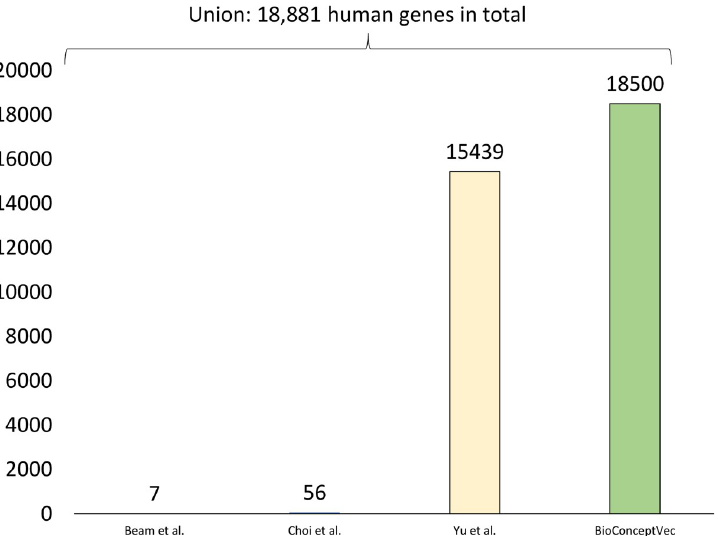
Fig 4. Gene coverage results in terms of human genes. The number of human genes in different embeddings is shown individually. In total, these four embeddings consist of 18,881 human genes. Note that the embeddings